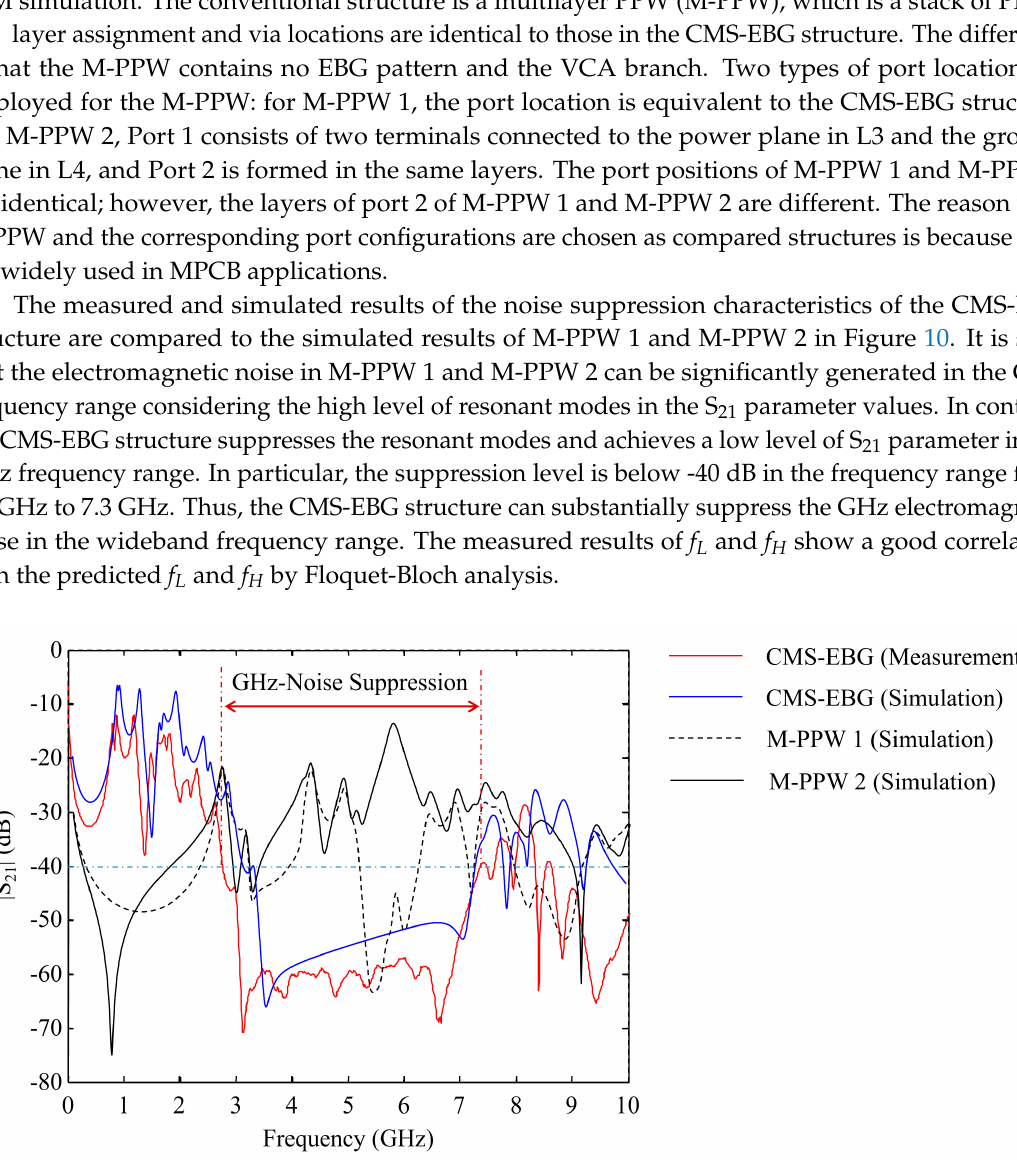
Figure 10. Comparison of the noise suppression characteristics between the CMS-EBG structure and the conventional multilayer parallel plate waveguide (M-PPW) structures.